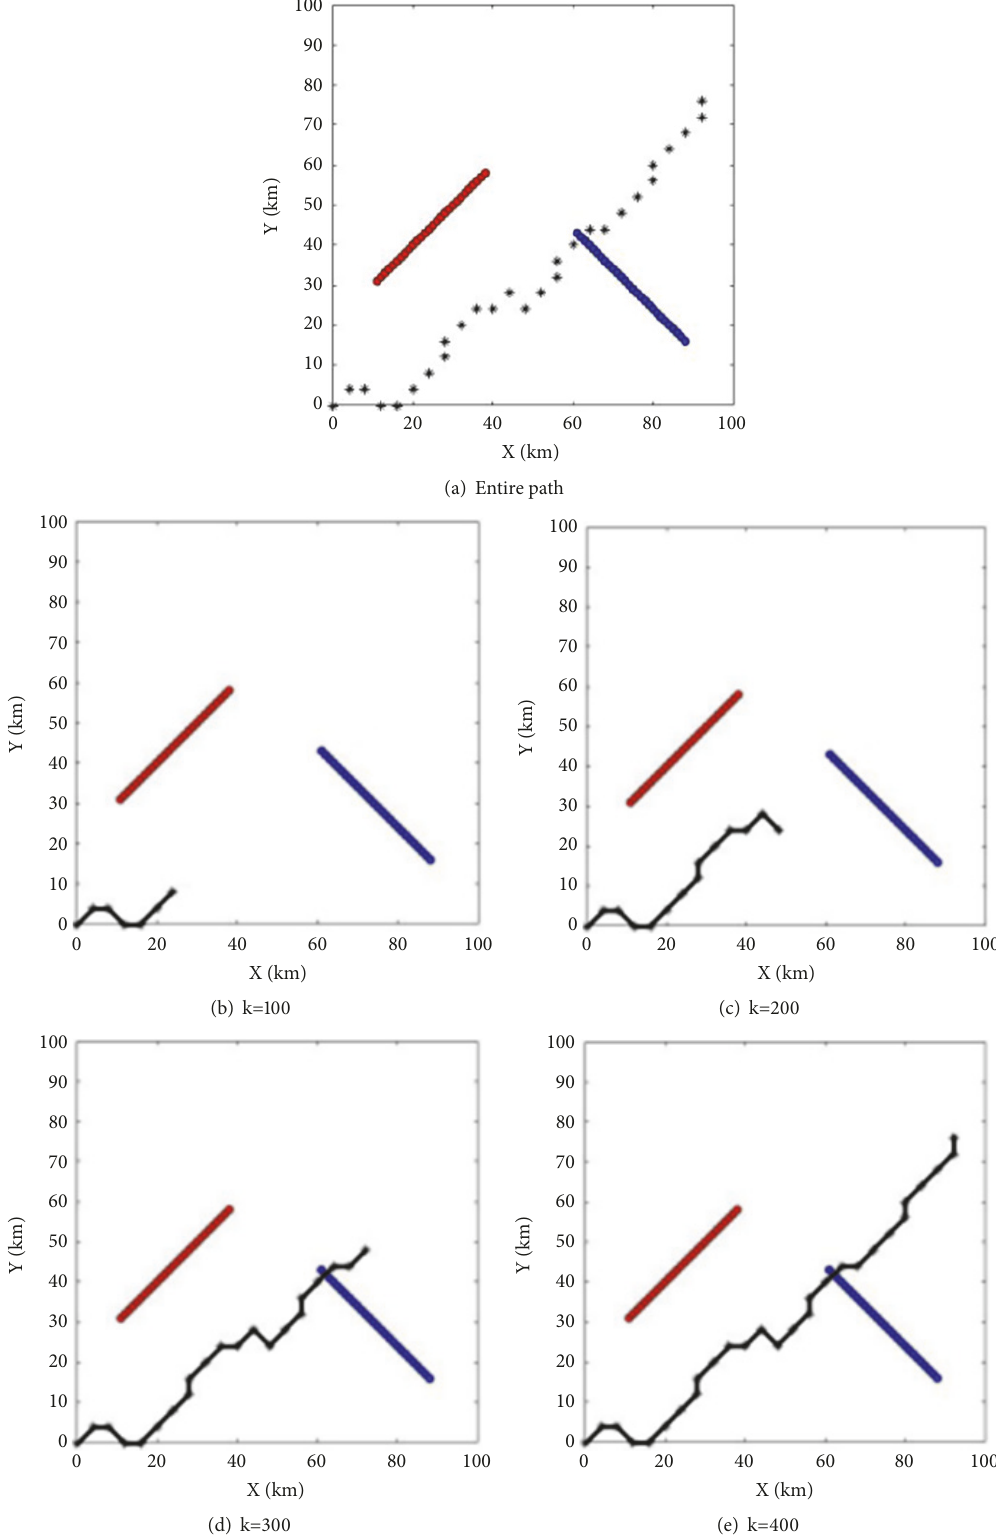
Figure 14: UAV path planning in another environment based on our proposed algorithm. And there are only mobile threats where (a) is an entire path and (b) to (e) are paths with iterations = 100, 200, 300,